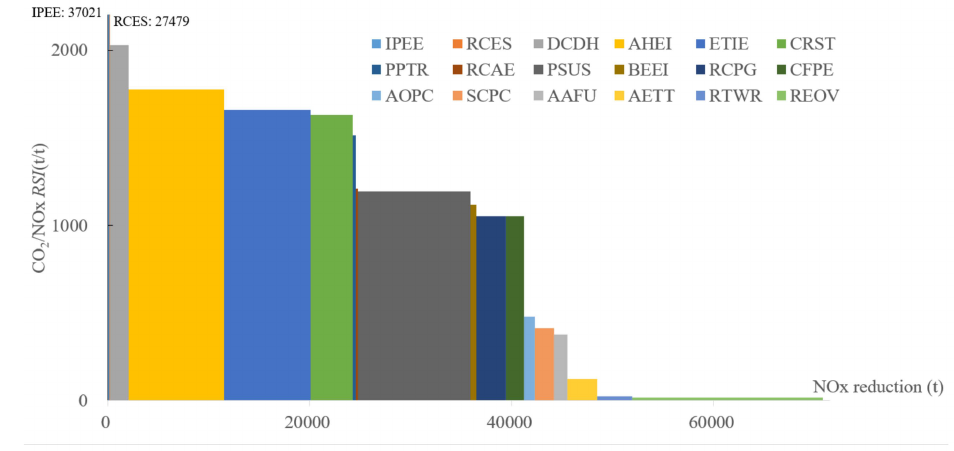
Figure 12. SRC of NO x and CO 2 emissions in 2030.